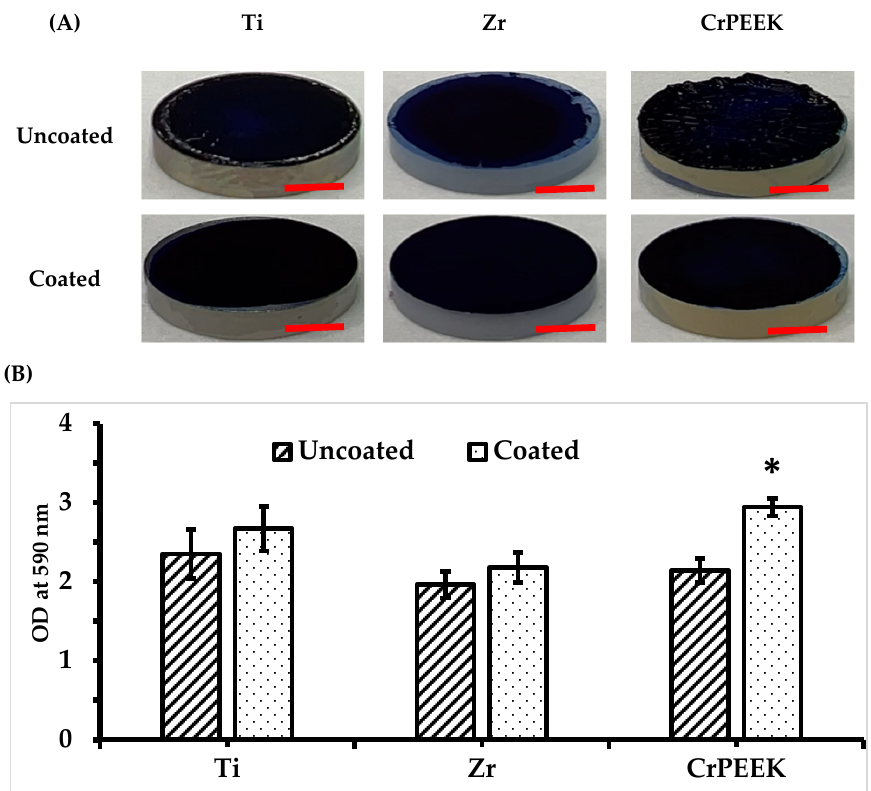
Figure 1. Coated and uncoated samples after CBB dye ( A ). A more uniform layer can be observed in coated samples and UV absorption of coated and uncoated samples analysed using a SpectraMax iD3 Multi-Mode Microplate Reader ( B ). Ti—Titanium; Zr—zirconium; CrPEEK—ceramic-reinforced PEEK. Scale bar: 0.3 cm. Values are mean + standard deviation, and * denotes statistical significance, p < 0.05 vs.